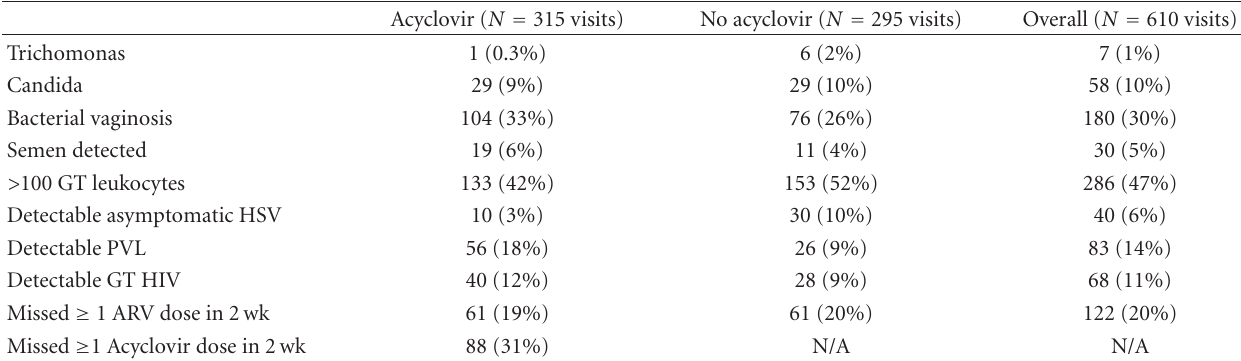
Table 2: Cumulative frequencies of clinical characteristics (visits